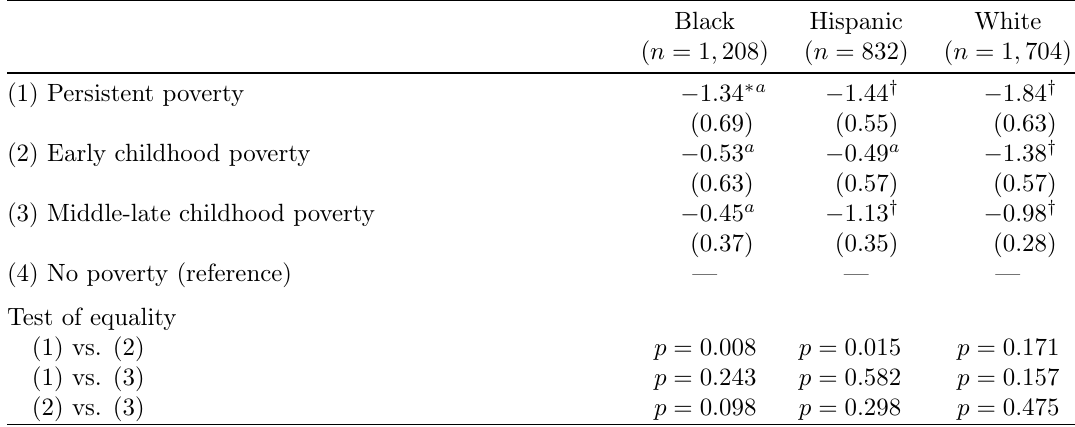
Table 5: Effect of Poverty Trajectories on High School Graduation, by Race/Ethnicity